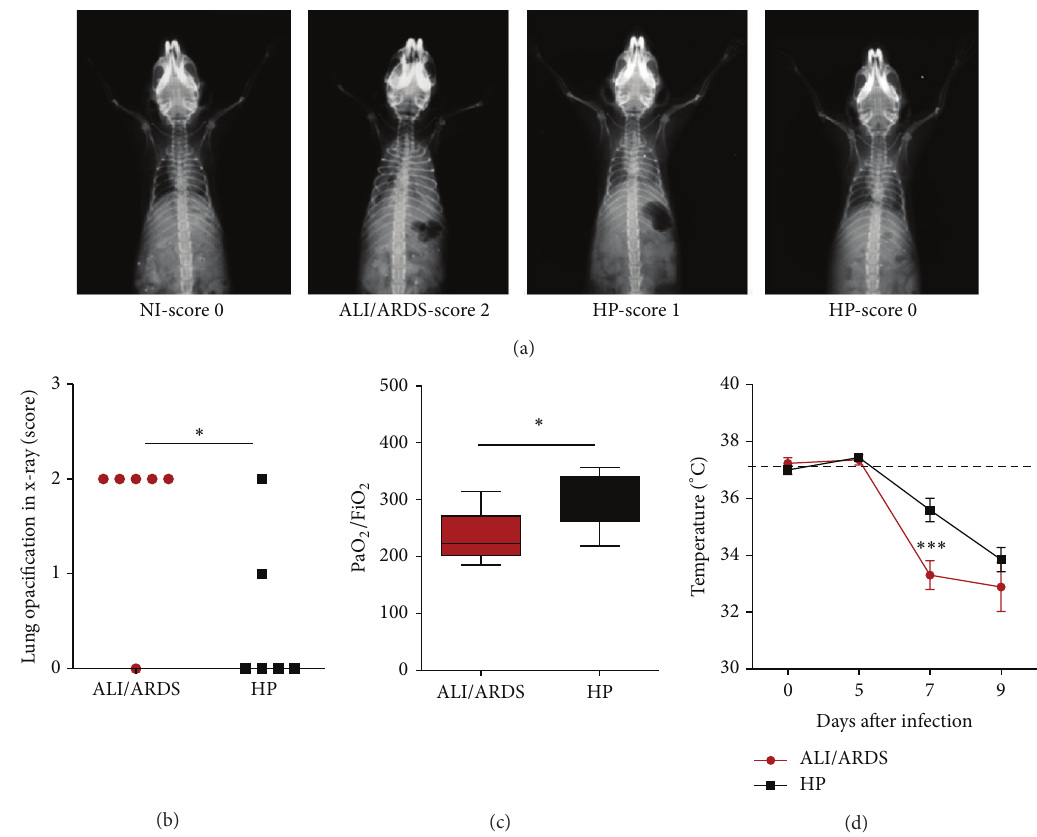
Figure 2: Radiography of the lungs, hypoxemia, and body temperature over time. (a) From left to right, X-rays from NI and infected DBA/2 mice that died with ALI/ARDS and HP showing different lung opacification scores on the 7th DAI. (b) Lung opacification scores on the 7th DAI. Mice that will later die with ALI/ARDS have a higher lung opacification score compared with mice that will die with HP ( 𝑛 = 12 ; ∗ 𝑃 ≤ 0.05 , Mann-Whitney test of scores taken from two separate experiments). NI mice do not have any lung opacification and are assigned score zero. (c) PaO 2 /FiO 2 values in P. berghei ANKA-infected mice on the 7th DAI. Results from three grouped experiments ( 𝑛 = 13 mice, ∗ 𝑃 ≤ 0.05 ; Mann-Whitney test). (d) Body temperatures in DBA/2 mice infected with P. berghei ANKA slightly increased on the 5th DAI from 37.1 ∘ C in the NI mice to 37.3 in the ALI/ARDS mice and 37.4 ∘ C in the HP mice). However, the temperatures dropped and the mice became hypothermic (especially the ALI/ARDS mice), with mean temperatures of 33.0 ∘ C on the 7th DAI and 32.8 ∘ C on the 9th DAI. Results are from three grouped experiments ( 𝑛 = 31 mice; ∗∗∗ 𝑃 ≤ 0.001 , two-way ANOVA with Bonferroni post test). Data (d) represents means and SEM. The dashed line represents the mean value of NI mice. NI: noninfected mice; ALI/ARDS: acute lung injury/acute respiratory distress syndrome; HP: